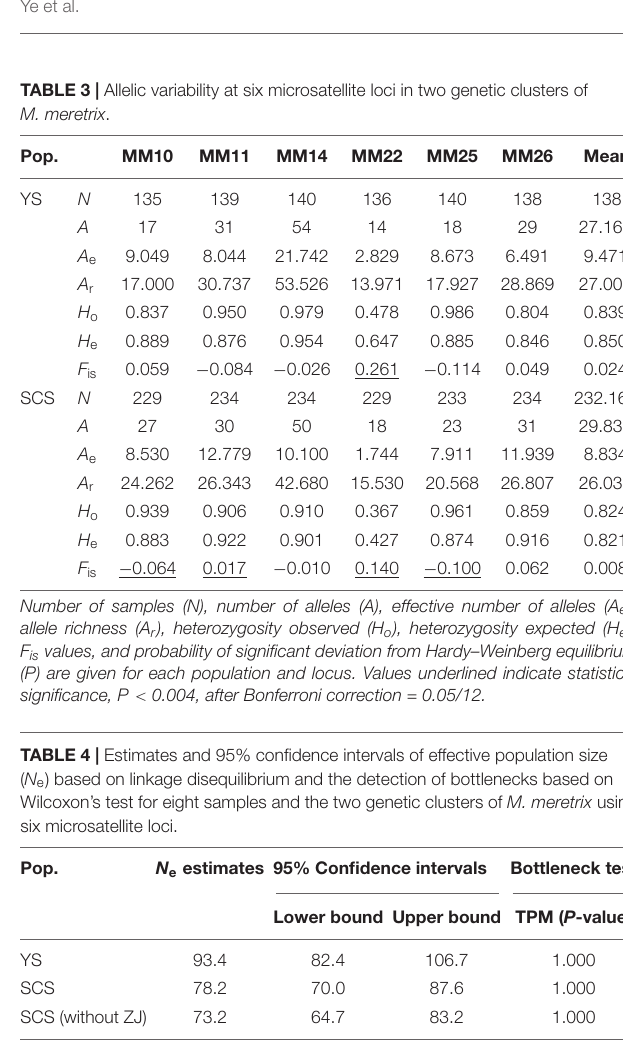
collect wild individuals there. F ST values suggested low, but significant genetic differentiation among some samples within the SCS.